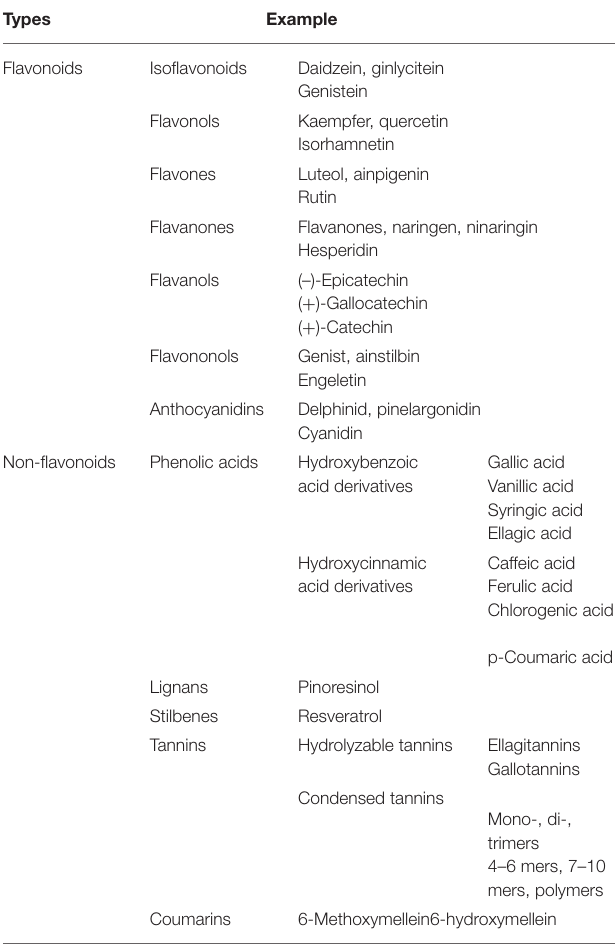
TABLE 1 | Different types of natural polyphenols